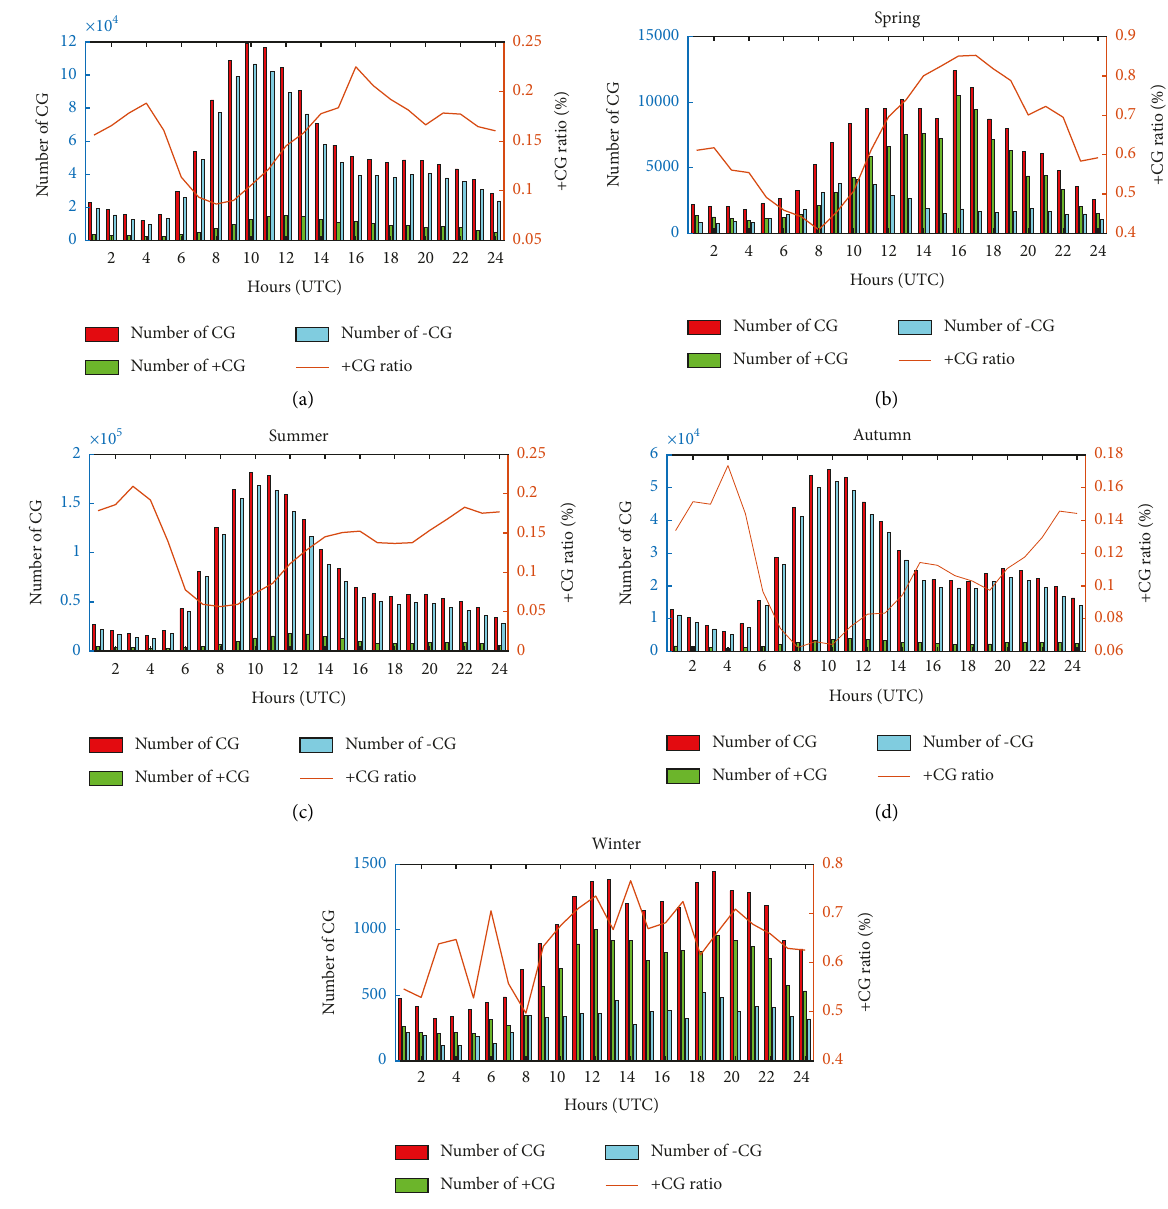
Figure 6: (a) Hourly distribution of the number of CG lightning flashes during 2009–2018. (b–e) Hourly distribution of the number of CG lightning flashes in the four seasons, in which the dashed line indicates the proportion of